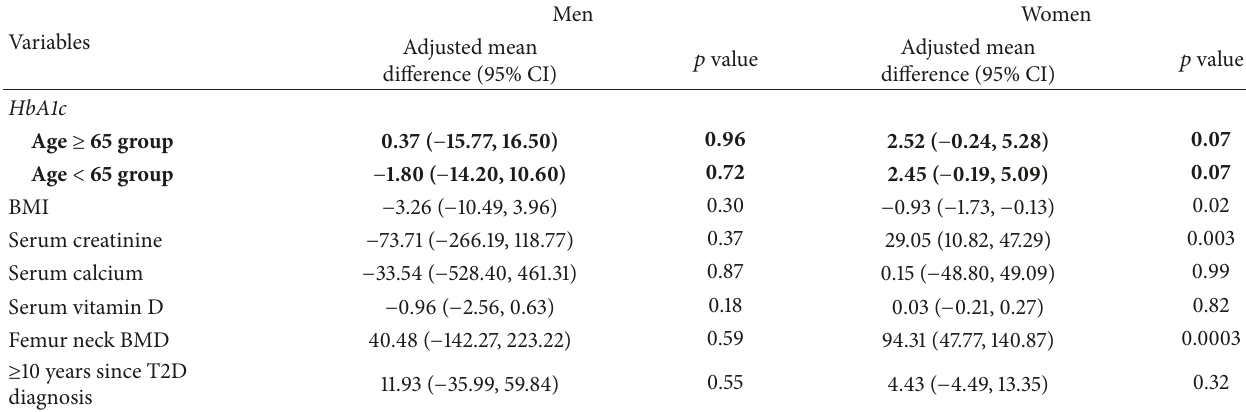
Table 3: Multivariable association between sclerostin and HbA1c for Mexican American men and women diagnosed with T2D.